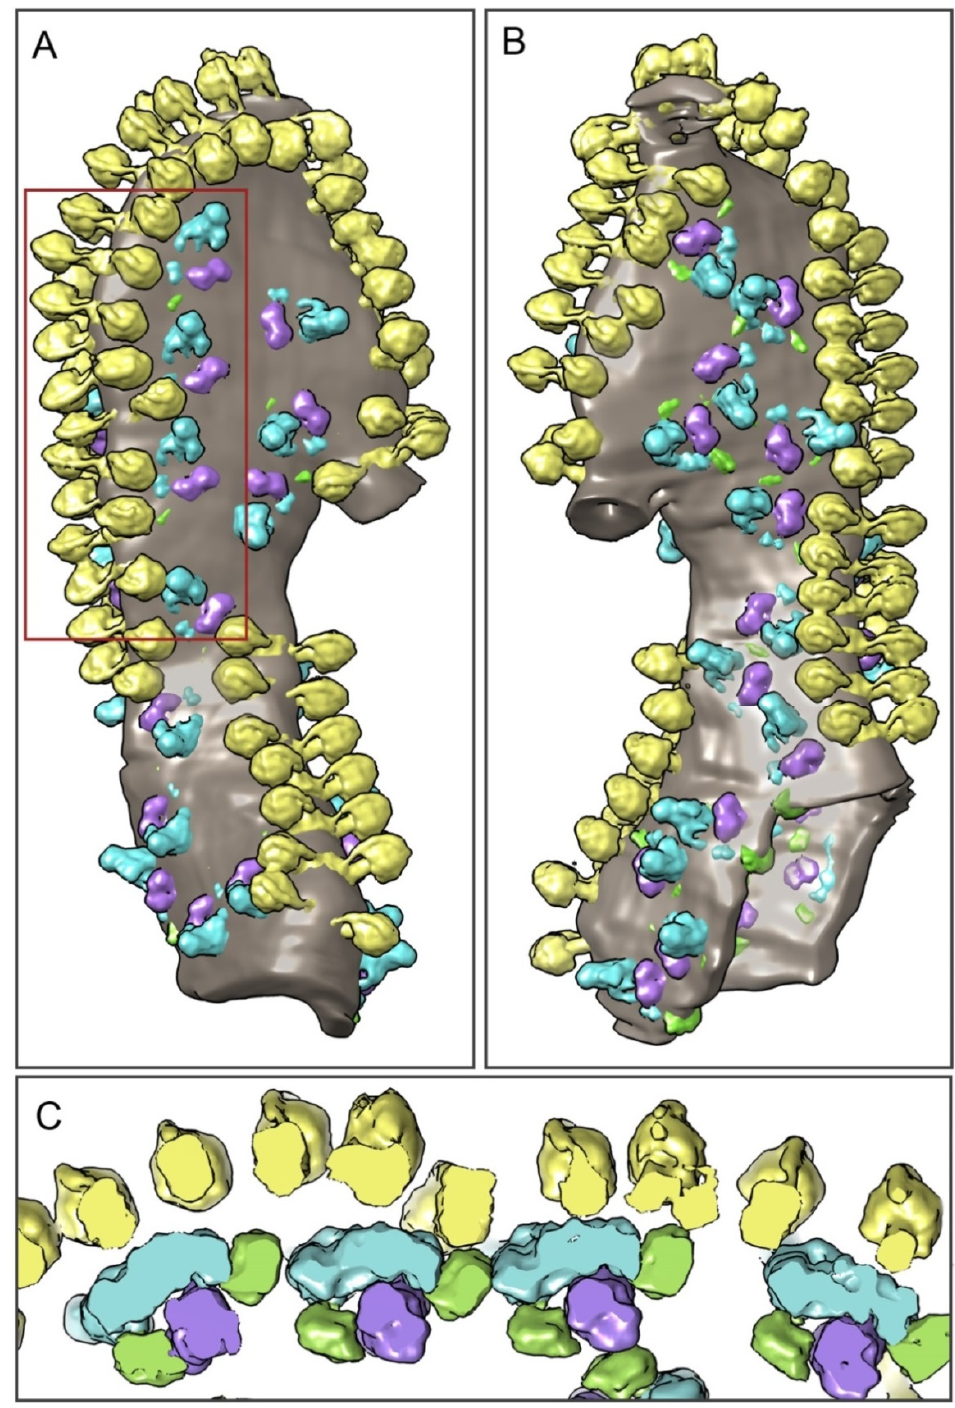
Figure 3. Surface rendering of the mitochondrial crista containing the oligomeric linear structure consisting of the respiratory chain and ATP synthases. ( A , B ) Views of the crista from the opposite sides (180° rotation around the vertical axis), demonstrating a highly ordered structure of the hypercomplex; ( C ) 3D visualization of respirasomes and the ATP synthases contact zones in the membrane. Slice of the fragment highlighted by the red frame in image ( A ). View from the opposite side of the membrane. Colors: yellow–ATP synthase, blue–complex I, purple–complex III dimer, green–complex IV.